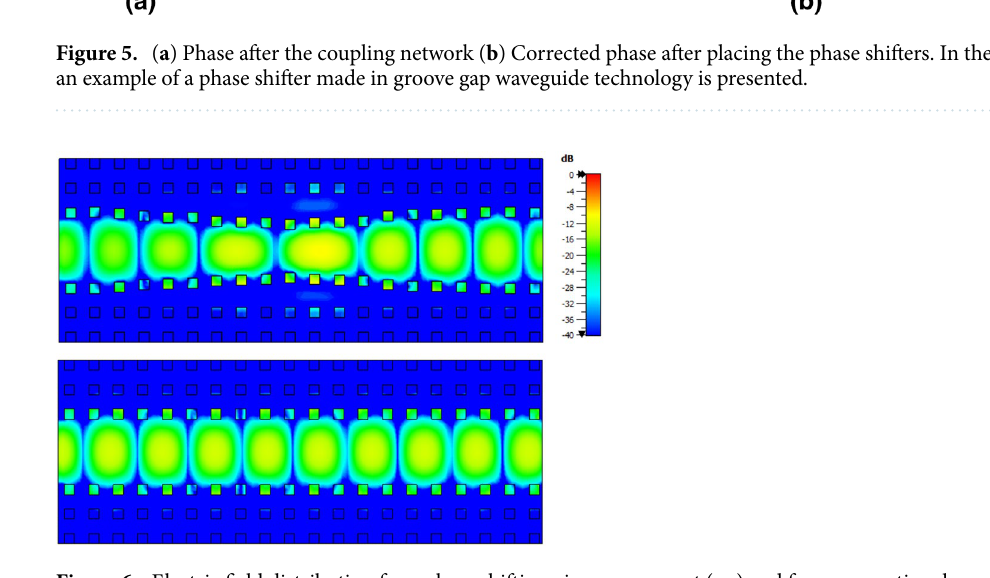
Figure 6. Electric field distribution for a phase shifting pin arrangement (up) and for a conventional gap waveguide made with pins (down).The color bar applies to both